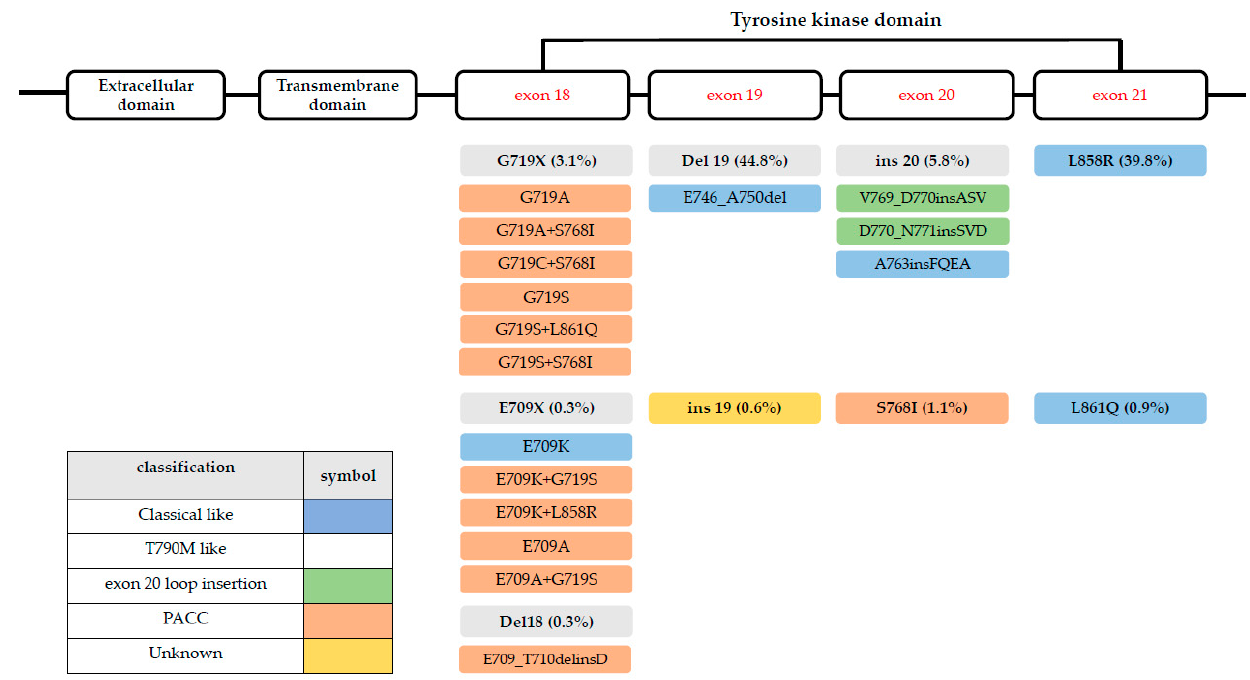
Figure 1. Structure of EGFR revealing common and uncommon mutations, compared with struc- tural-based classification [18,19]. We have listed the mutations which are seen in more than 5% in each subgroup ( 719X , E709X , etc.), and assigned structural classifications.